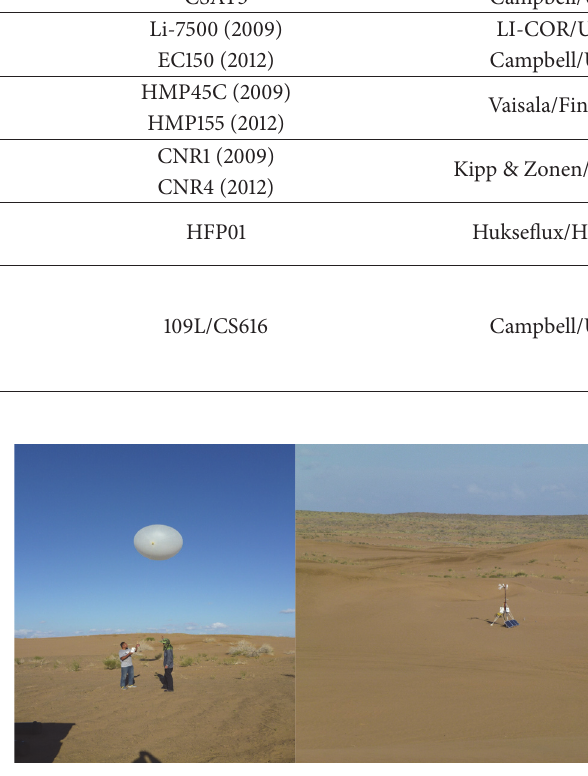
Figure 2: Geographic environment and ABL experiment observation field in Badain Jaran taken on July 4,